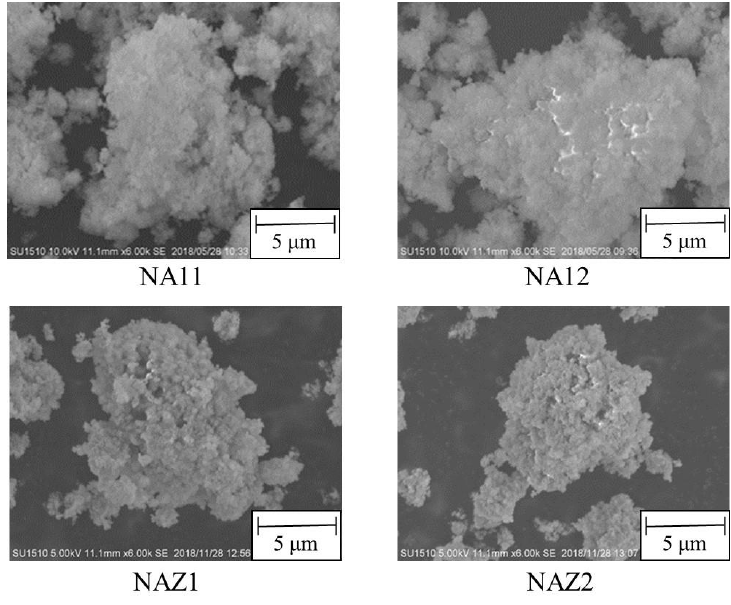
Figure 1. SEM images of adsorbents.